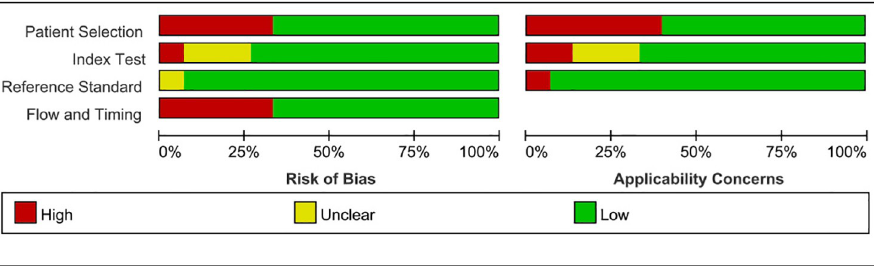
Fig 2. Methodological quality of the studies included in this